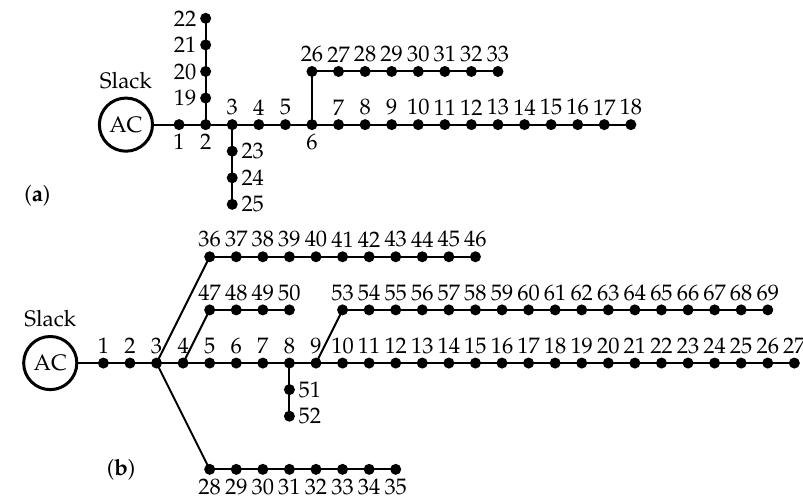
Figure 4. Test feeders: ( a ) IEEE 33-bus system and ( b ) IEEE 69-bus system.